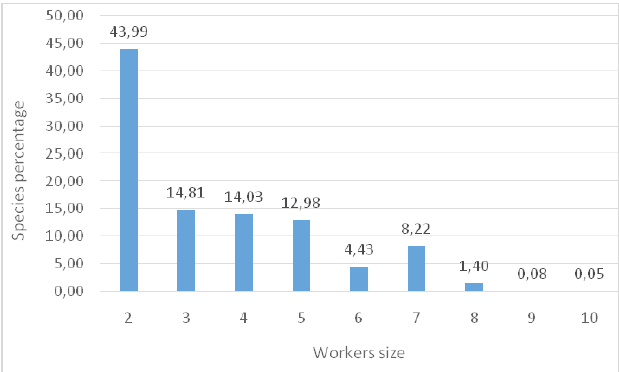
Fig 4 . The species percentages’s representation according to the workers size harvested by all sampling methods used (Winkler, pitfall, baits and manual capture) and in the three study stations of the Guerrouche forest